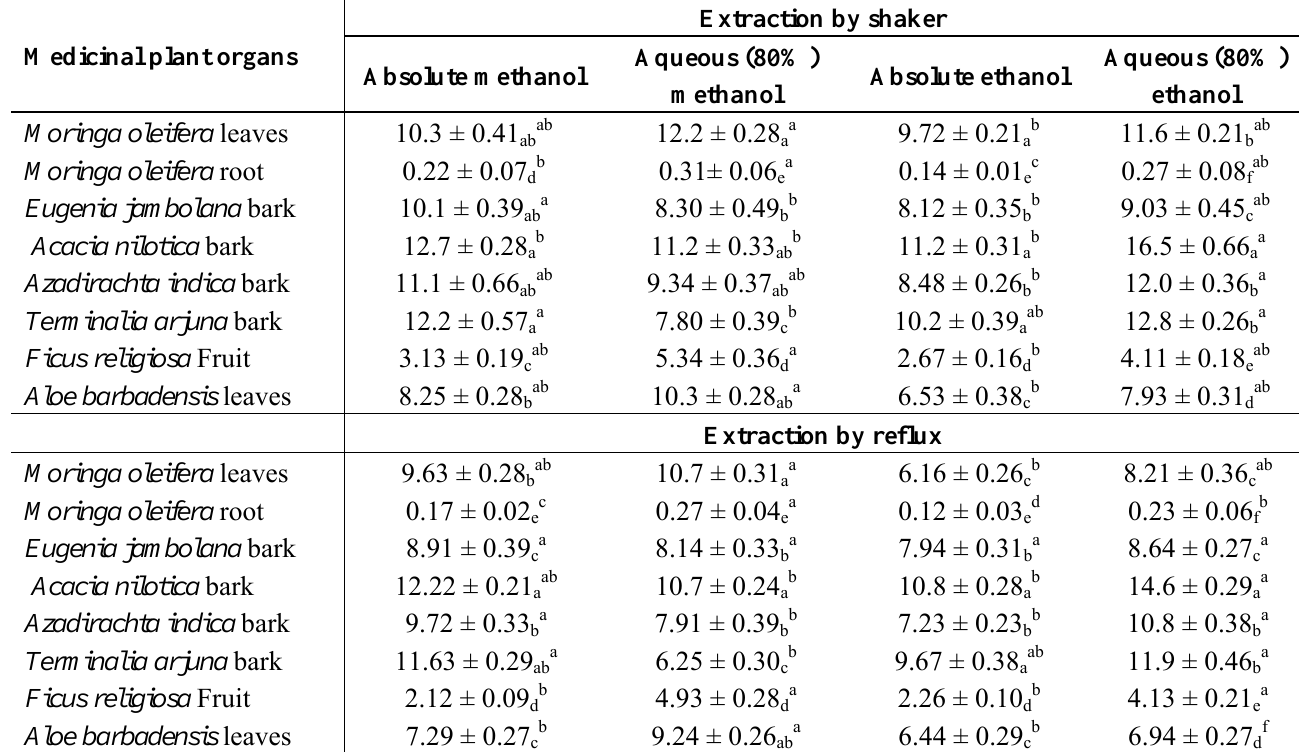
Table 2. Effects of extracting solvent/technique on the total phenolic contents (GAE g/100 g of DW) of medicinal plants